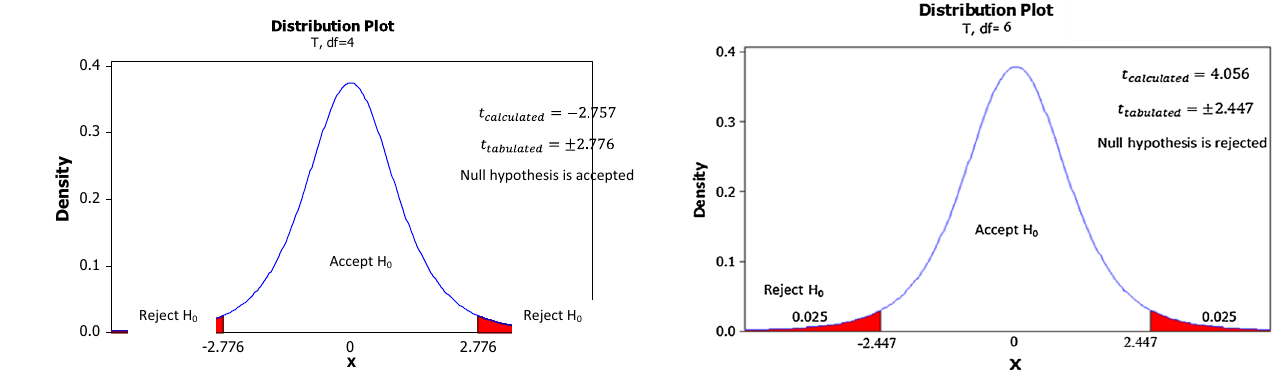
Fig. 3 Probability chart for t distribution for two-tailed test Fig. 4 Probability chart for t distribution for paired t